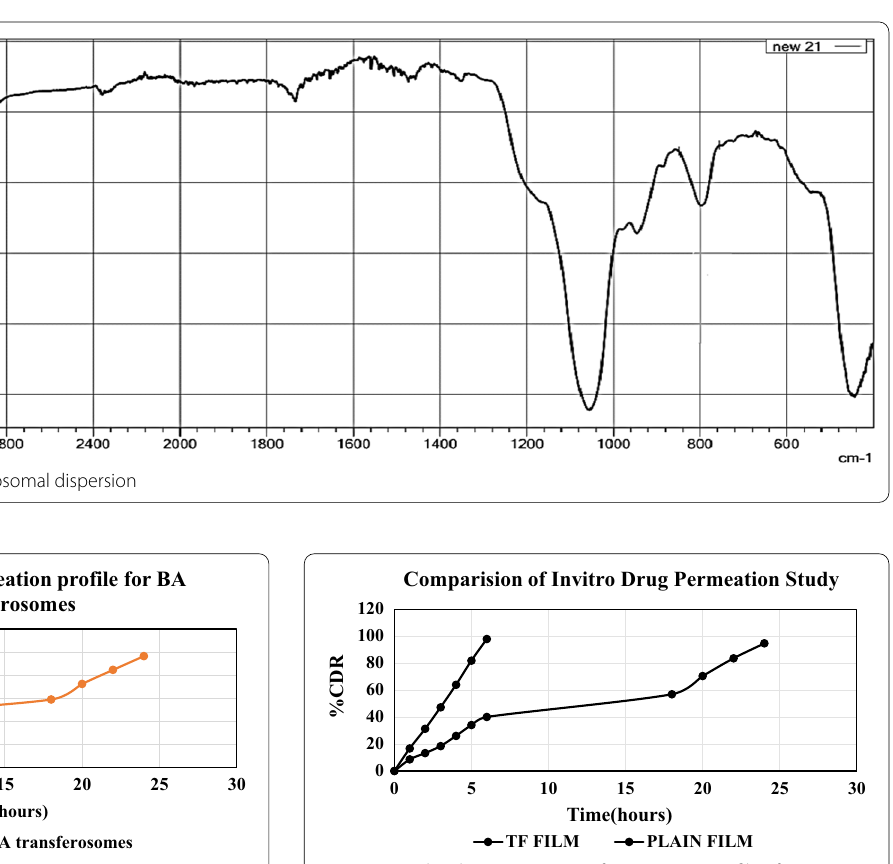
Fig. 13 Graphical representation of in vitro drug permeation from BA transferosomal dispersion